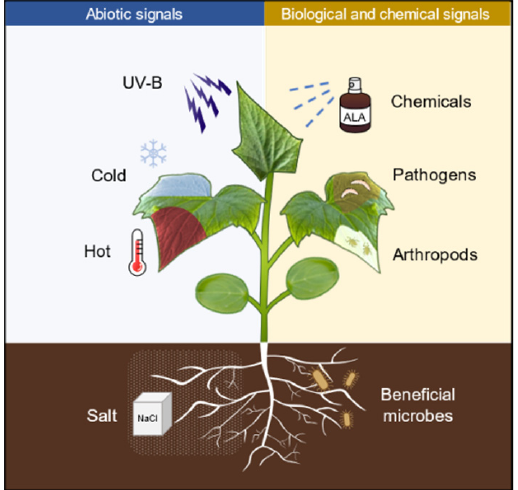
Figure 1. Numerous biotic and abiotic stress as well as defense-related chemicals are capable of inducing plants into priming status. UV-B, ultraviolet B (UVB); ALA, 5-aminolevulinic acid; NaCl, sodium